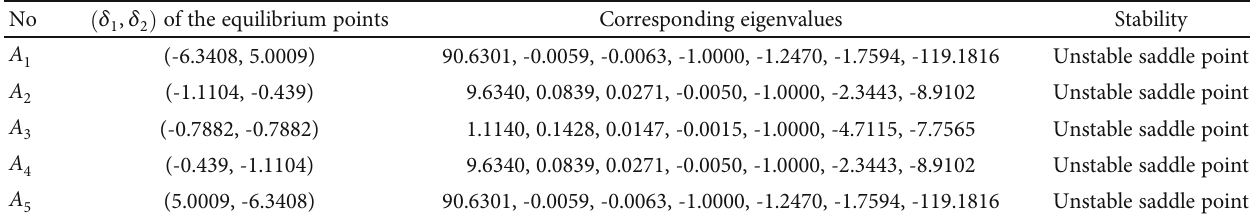
Table 1: Equilibrium points, eigenvalues, and stabilities when k = 0 : 1 .